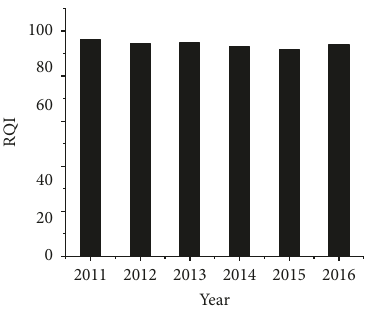
Figure 2: Continuous statistics of the driving quality index chart.